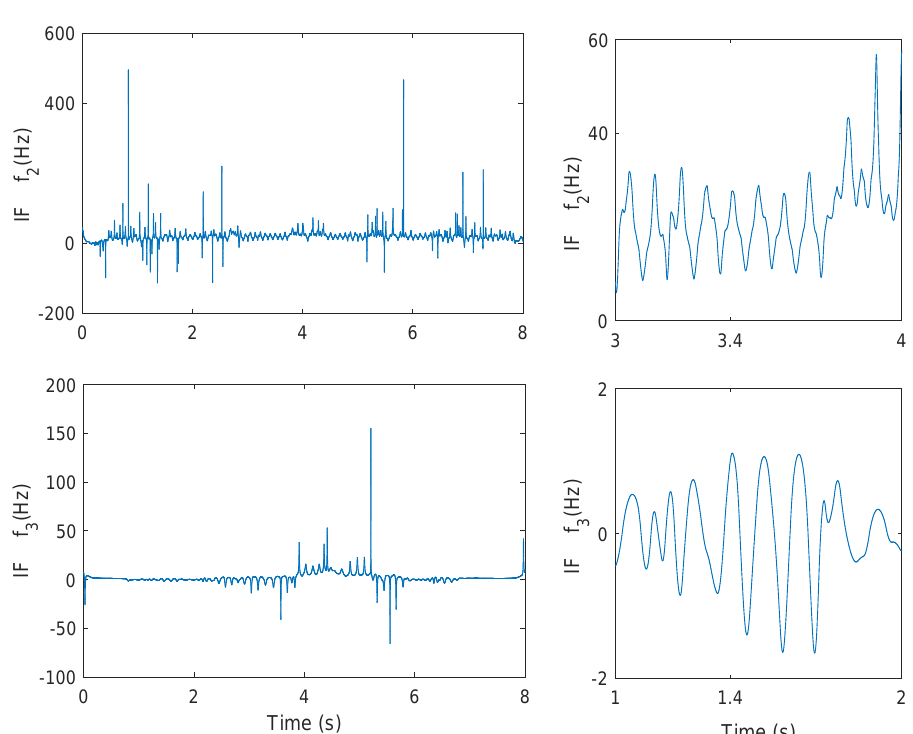
Figure 15. IFs f 2 ( t ) and f 3 ( t ) ( left ), zoom of IFs f 2 ( t ) and f 3 ( t ) ( right